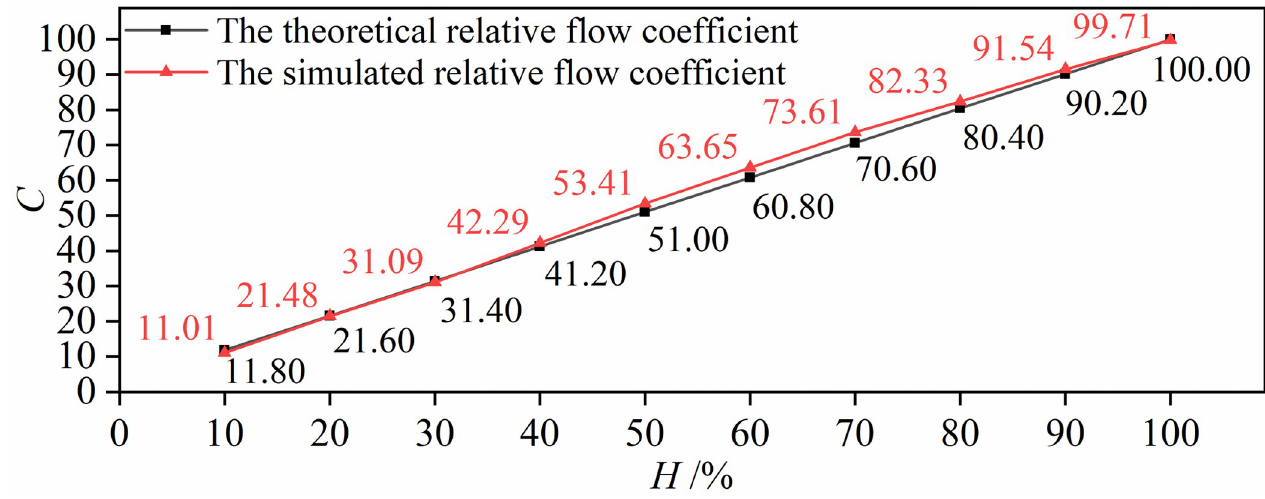
Fig 4. Comparison of the simulated relative flow coefficient with theoretical values.